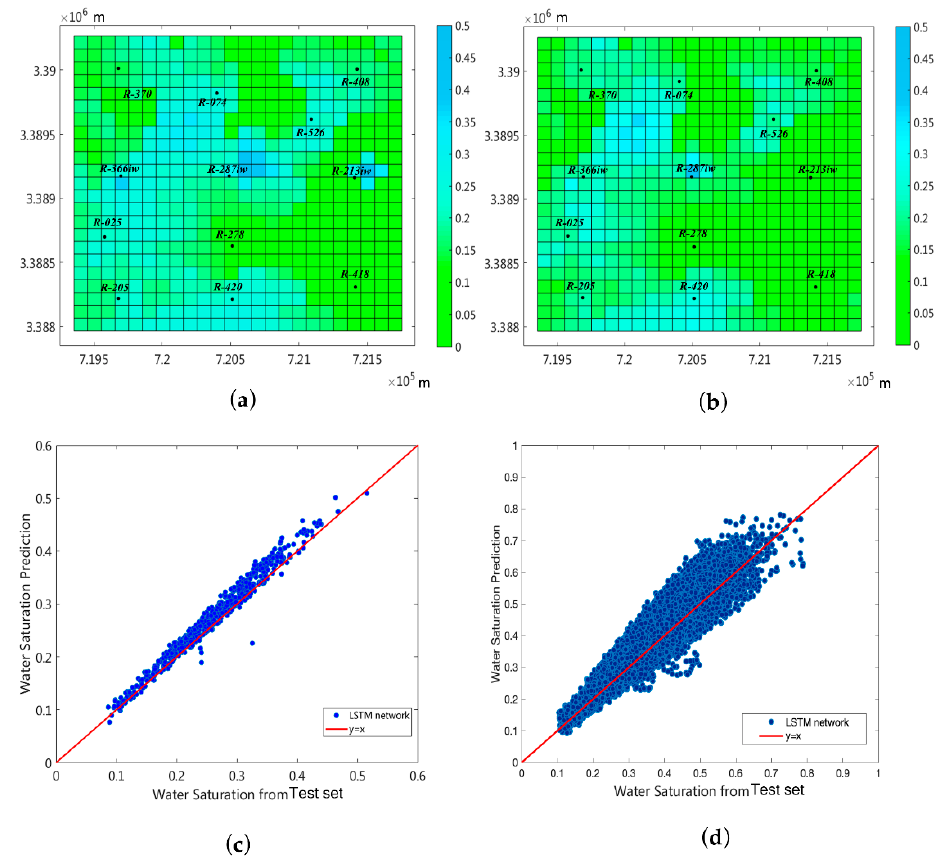
Figure 12. Comparison between Test set data and LSTM results at 48th month of prediction (148th month in whole time sequence) for water saturation distribution: ( a ) Water saturation distribution from Test set; ( b ) water saturation distribution from LSTM prediction; ( c ) Cross plot of water saturation distribution for 22nd layer; ( d ) Cross plot of water saturation distribution for all layers.